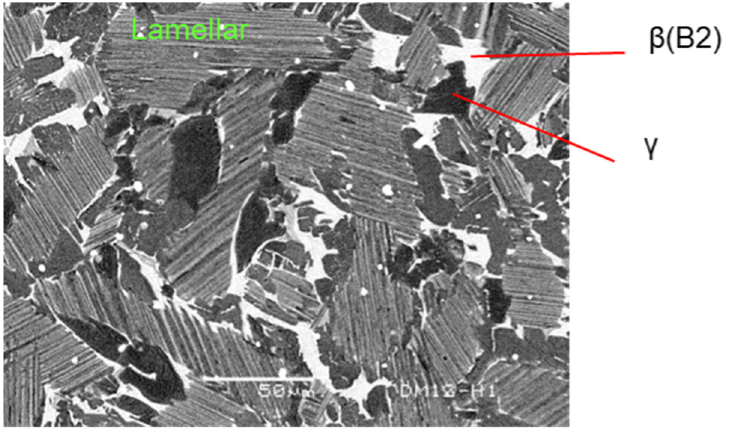
Figure 5. BSE image showing the microstructure of hot-forged Ti-42Al-5Mn after heat treatment.